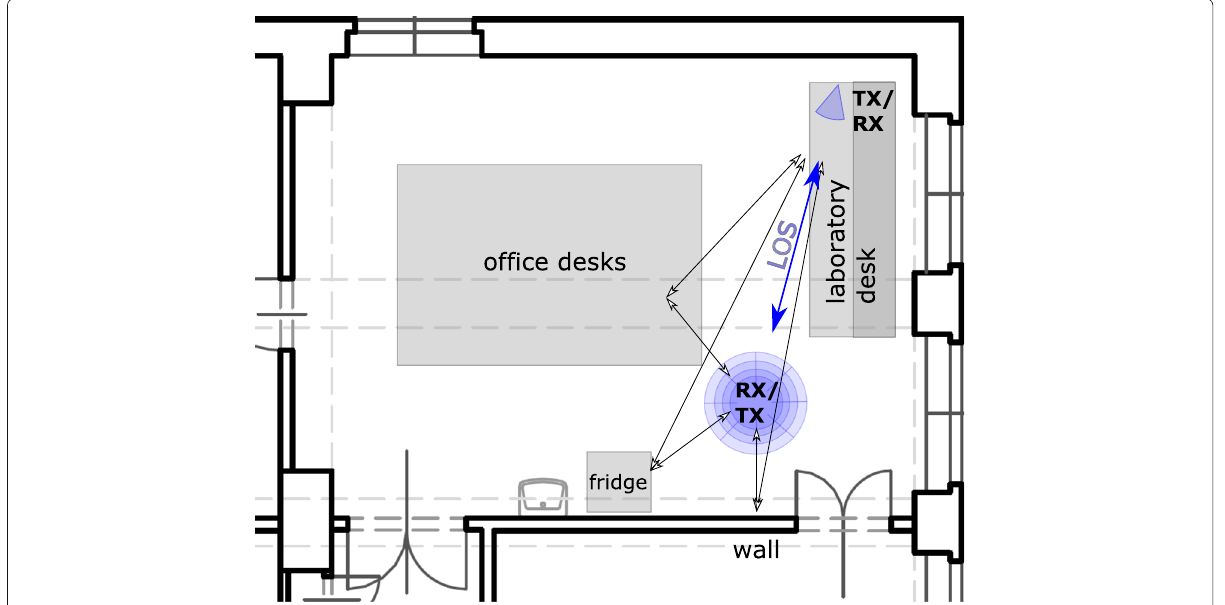
Fig. 3 Floor plan of the measured environment. The floorplan indicates the multipath components that are visible in the measurement results. TX and RX switch roles for MC2. TX/RX in the right upper corner of the room is always static. RX/TX in the middle of the room is steerable, indicated by the spider’s